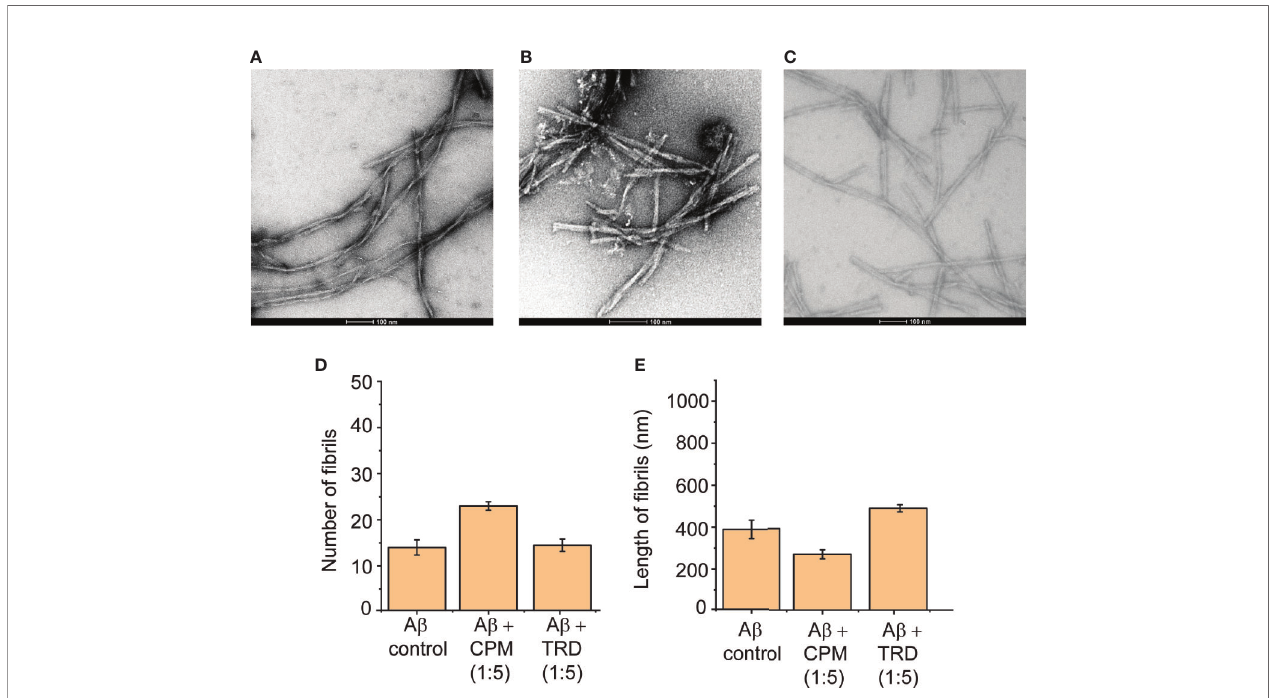
FIGURE 4 | Direct interaction between CPM and TRD with A b (1 – 40) peptides in a 1:5 ratio. (A) TEM image of A b control grown for 60 h at 37°C under continuous shaking. (B) TEM image of 50 µM A b control grown in the presence of 250 µM CPM (1:5 ratio) for 60 h at 37°C under continuous shaking. (C) TEM image of A b control grown in the presence of 250 µM TRD (1:5 ratio) for 60 h at 37°C under continuous shaking. (D) Number of fi brils for each condition measured from the TEM images. (E) Length of fi brils for each condition measured from the TEM